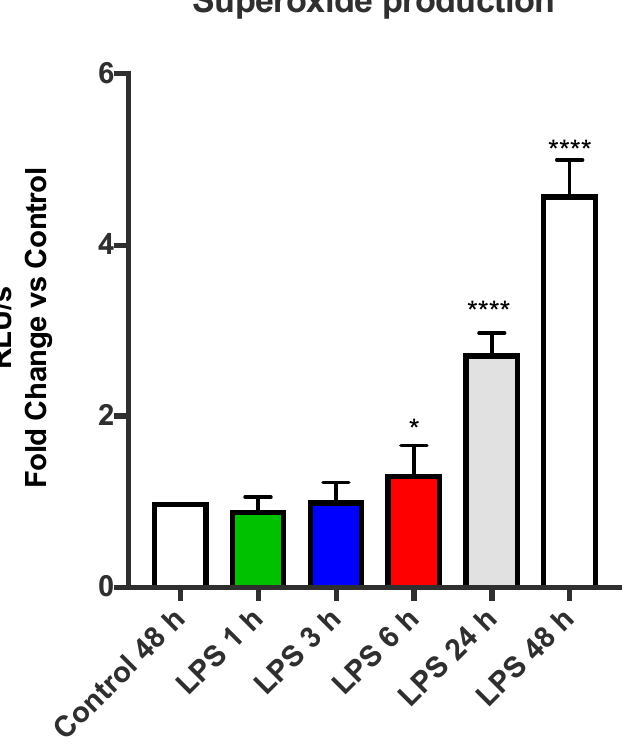
Figure 1. TLR4 activates the NOX2 oxidase-dependent oxidative burst in macrophages. Oxidative burst measured by L-012-enhanced chemiluminescence in RAW 264.7 cells stimulated with the TLR4 agonist LPS (100 ng/mL) over 48 h, 24 h, 6 h, 3 h and 1 h. Data are presented as mean ± SEM of n = 7–8 experiments. Data are expressed as a fold change against the respective control in relative light units (RLU), measured as an average of triplicates over a 60-cycle period, subtracted by blank readings. Statistical analysis was conducted via a Student’s t -test. * indicates p < 0.05 against control and **** indicates p < 0.0001 against control.